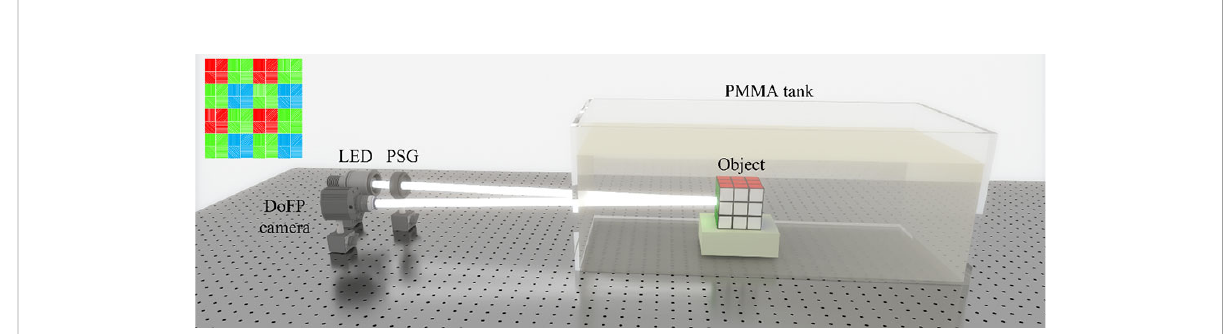
FIGURE 2 Simulation diagram of the experimental setup for dataset acquisition. The scattering medium shown in the simulation diagram is full cream milk. The RGB-polarization pattern array of chromatic DoFP polarization camera by Lucid vision is at the top-left